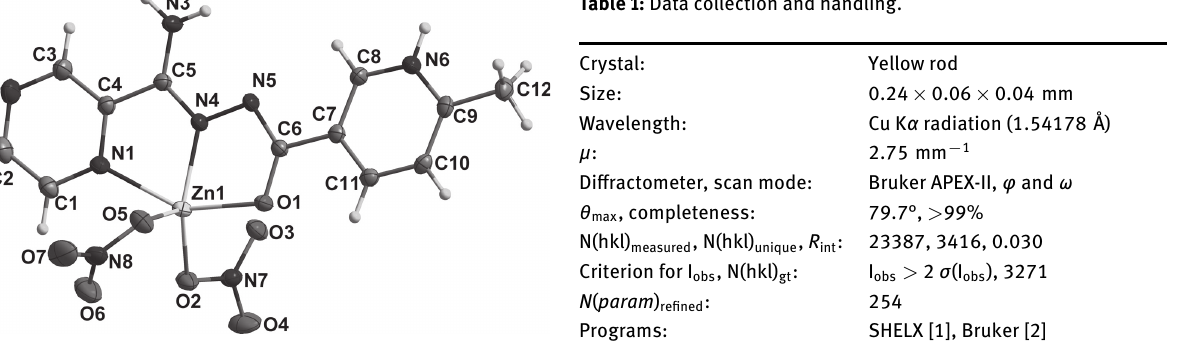
Table 1: Data collection and handling.